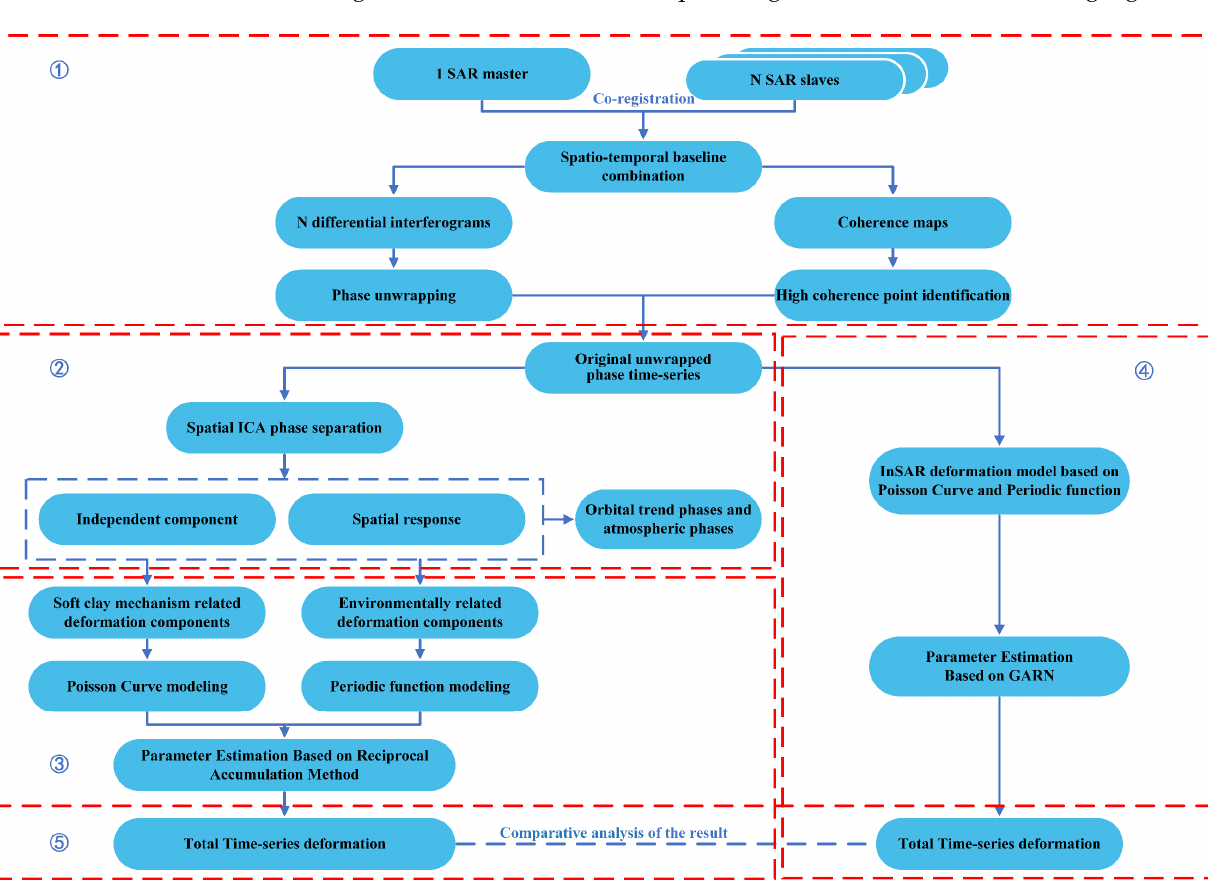
Figure 1. Flow chart of the FIPR algorithm.